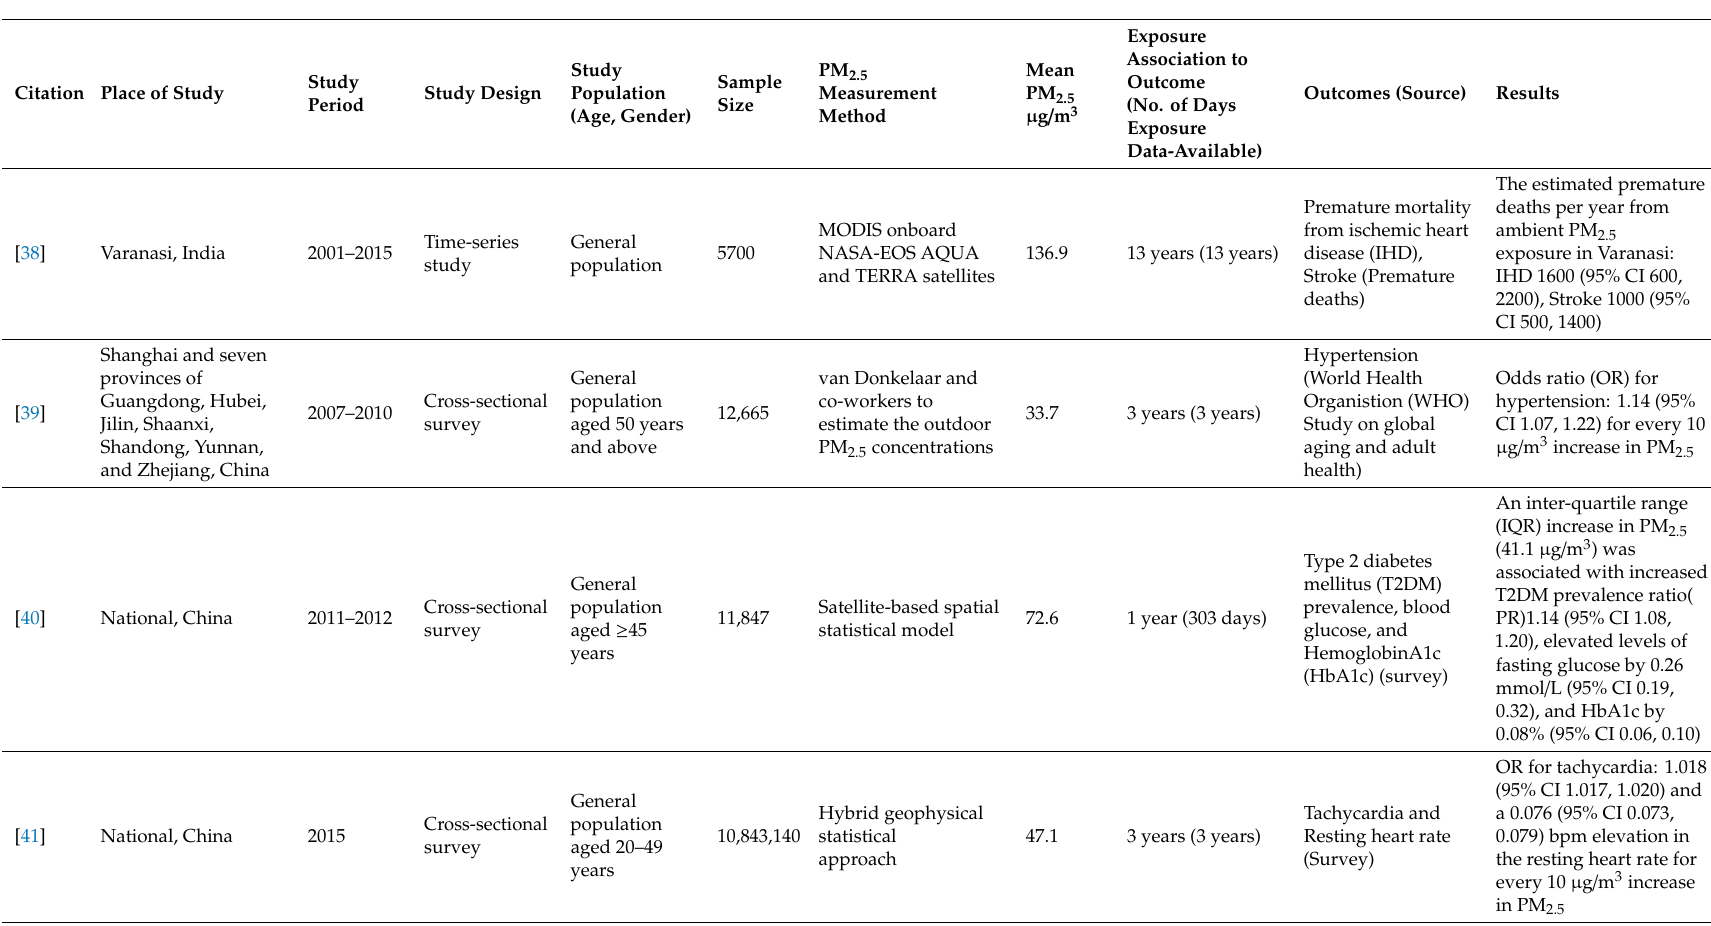
Table 2. Study characteristics, exposure, outcome, and primary results of included studies ( n = 6, listed alphabetically) measuring PM 2.5 exposure as annual average or